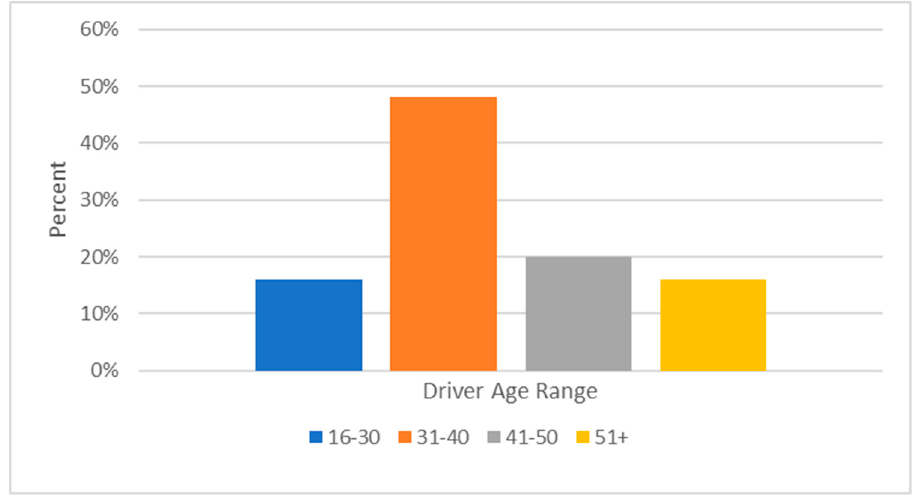
Figure 1. Driver age range.